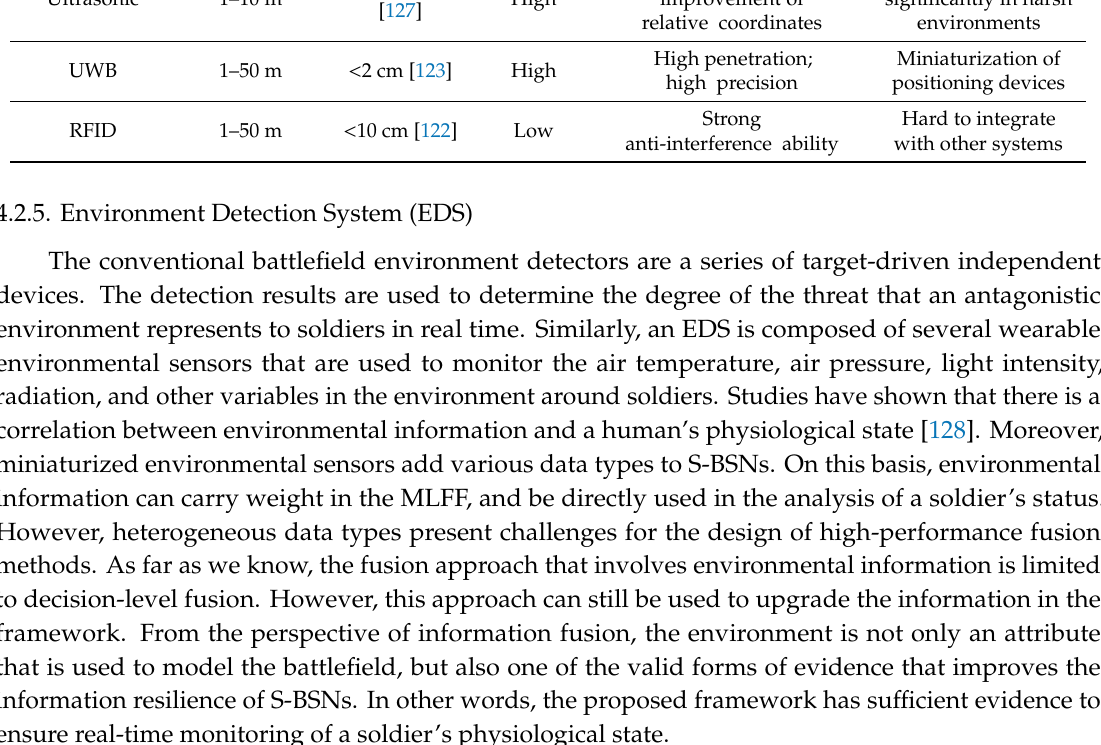
Data processing; Strong anti-interference errors ability; high utilization rate